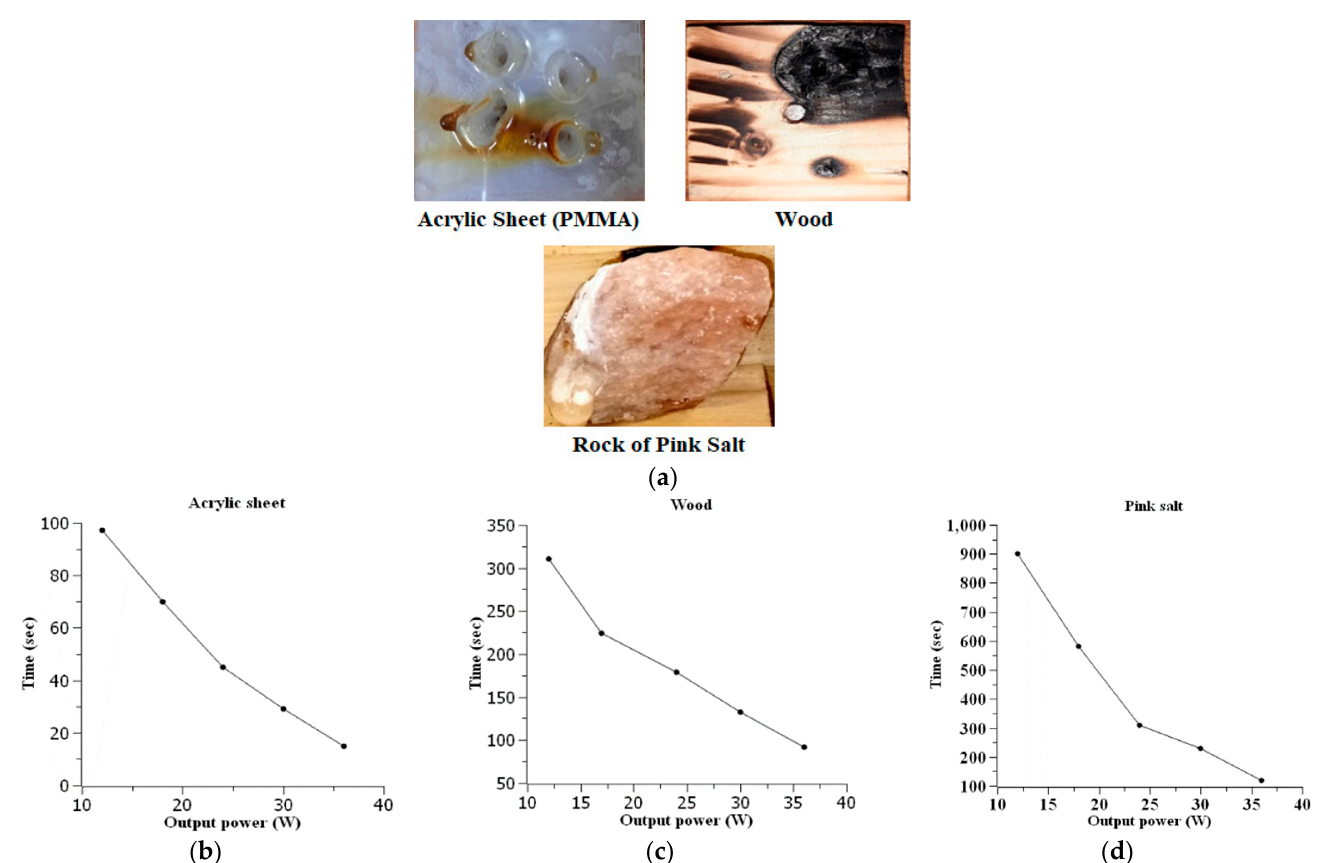
Figure 4. ( a ) Snap of samples after analysis. Penetration time variation along output power for ( b ) acrylic sheet (thickness = 30 mm). ( c ) Wood (thickness = 12 mm). ( d ) Rock of pink salt (thickness = 5 mm).